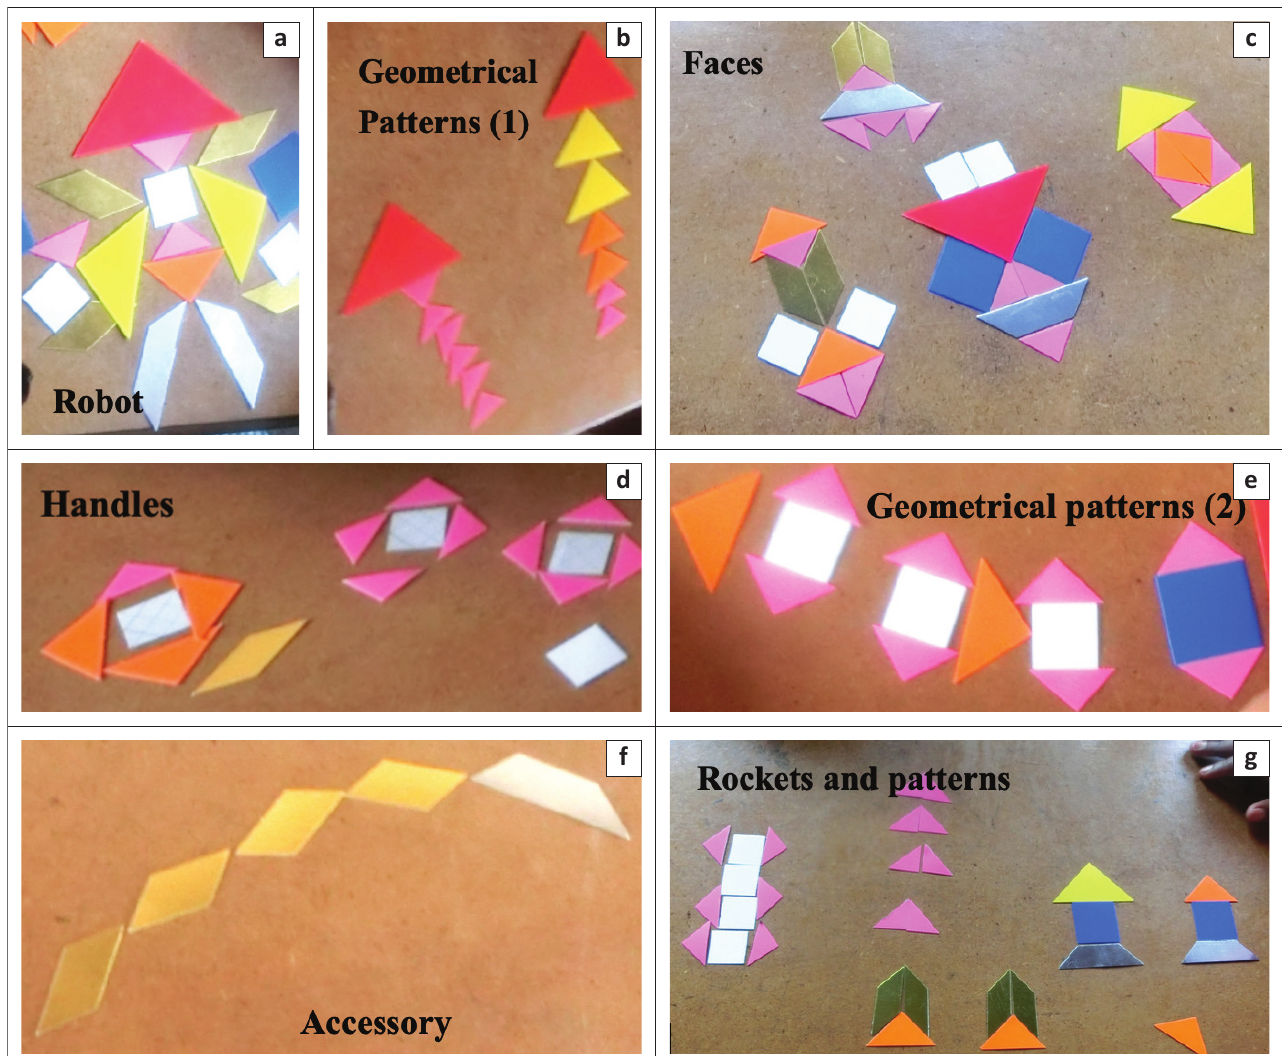
FIGURE 6: Other interesting figures that children made in the second